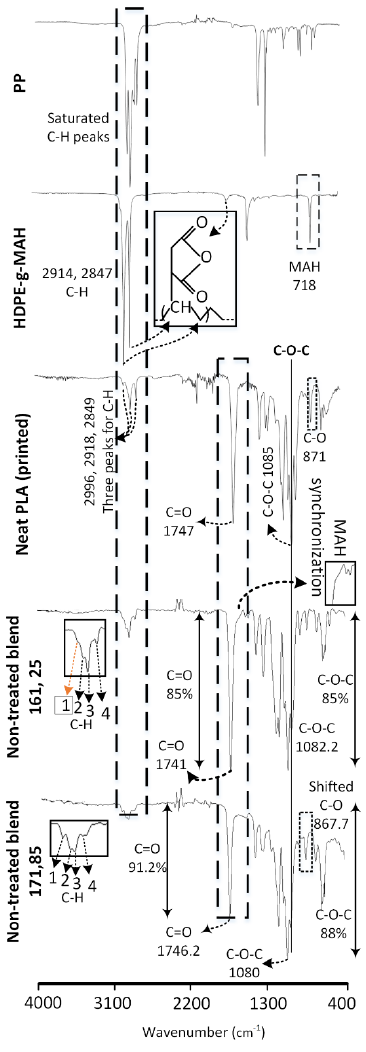
Figure 4. FTIR analysis for effects of melt blending on non-treated blend.